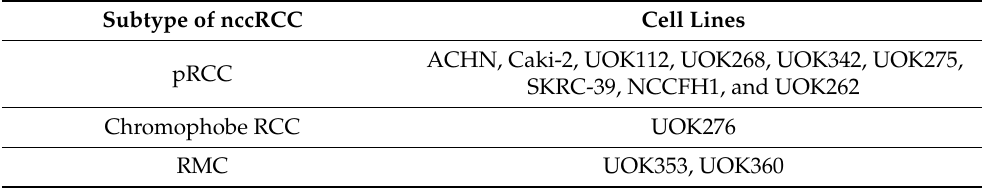
Table 1. Cell lines of different subtypes of non-clear cell renal cell carcinoma (nccRCC). Subtype of nccRCC Cell Lines pRCC Chromophobe RCC